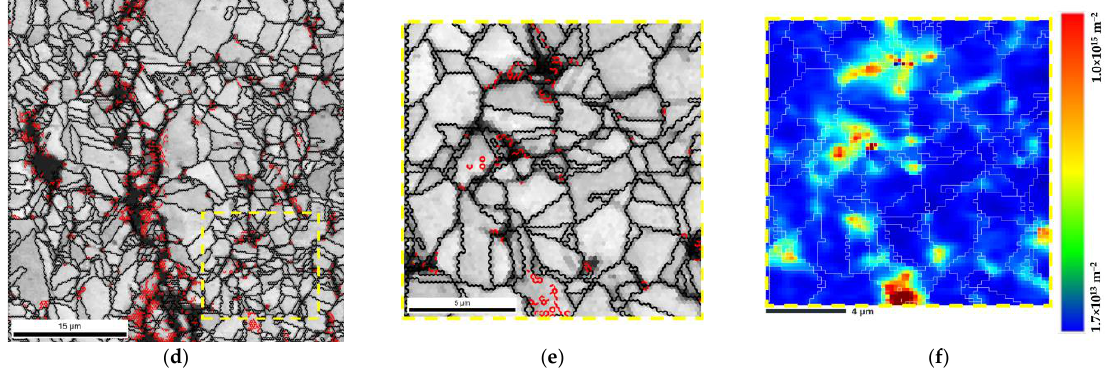
Figure 11. ( a – c ) Cu and ( d – f ) Cu/CNT (1.0% vol.) samples were analyzed using ( a , b , d , e ) IQ maps with high- (black) and low-angle (red) boundaries and ( c , f ) GND estimated density maps of the area marked in ( a ) and ( d ).